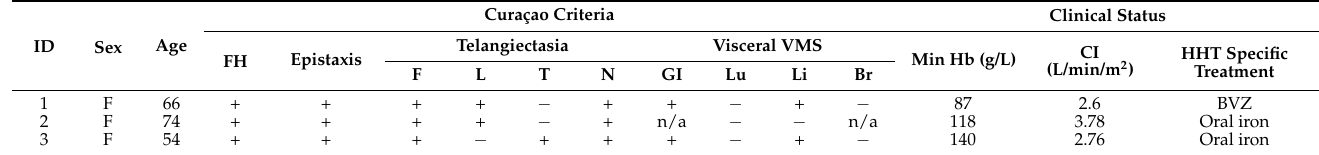
Table 1. Clinical data of patients with splice site variants in ENG and ACVRL1